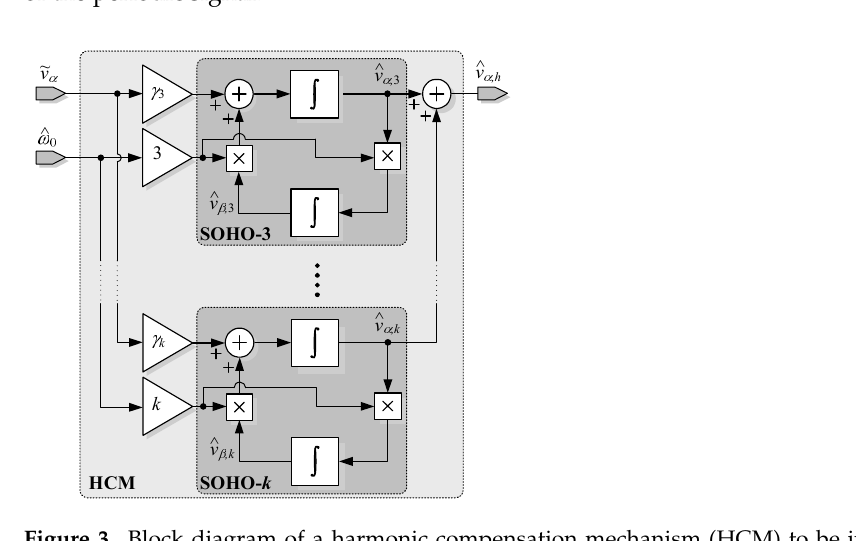
Figure 3. Block diagram of a harmonic compensation mechanism (HCM) to be included in the proposed SOHO-based FLL.